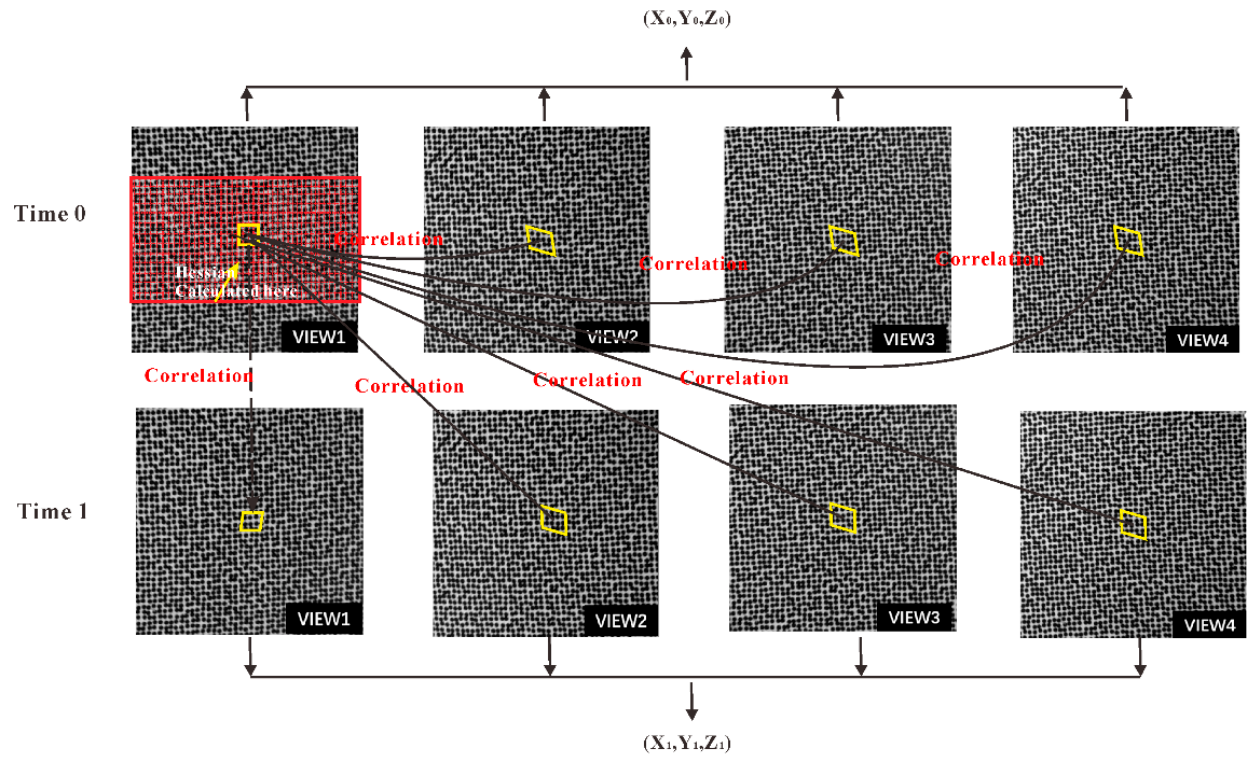
Figure 5. Four-view stereo vision matching and sequence image matching.